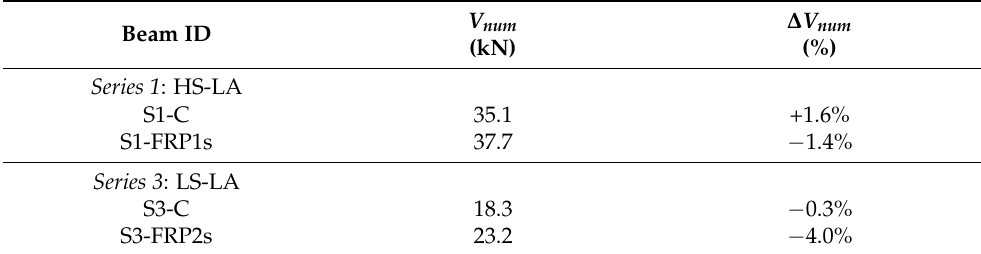
Table 6. Comparison of FE and experimental maximum shear force.